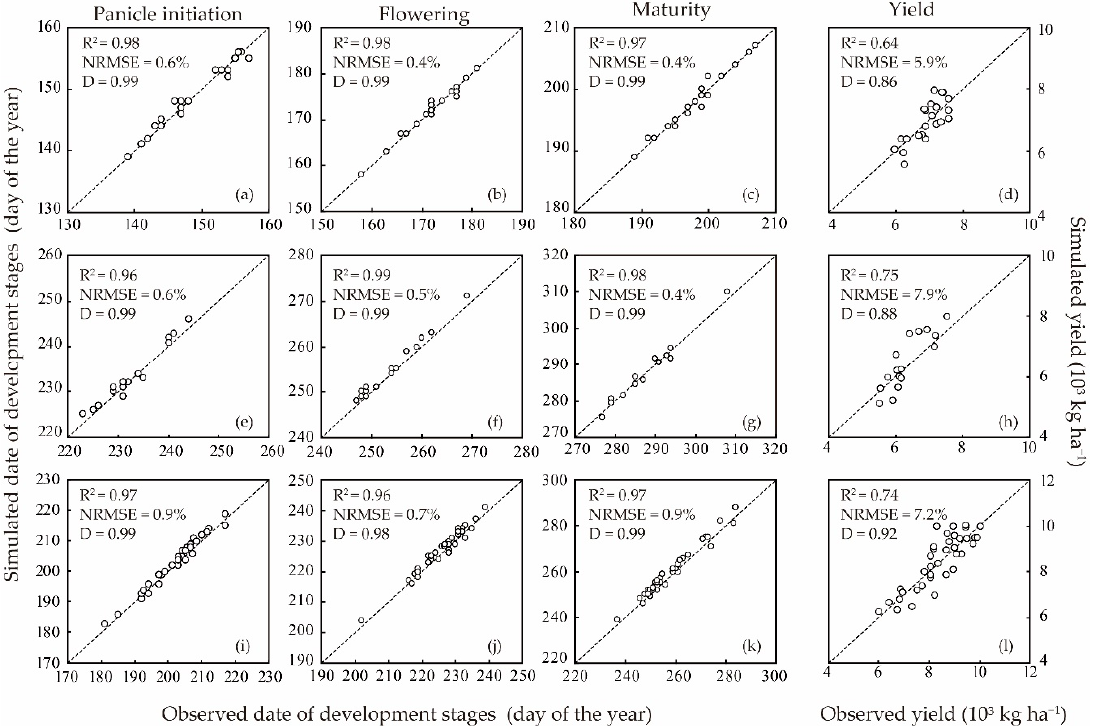
Figure 2. Comparison of the simulated and observed date of panicle initiation ( a , e , i ), flowering ( b , f , j ), physiological maturity ( c , g , k ), and grain yield ( d , h , l ) for early rice ( a – d ), late rice ( e – h ) and middle rice ( i – l ). The dashed line represents the 1:1 line.